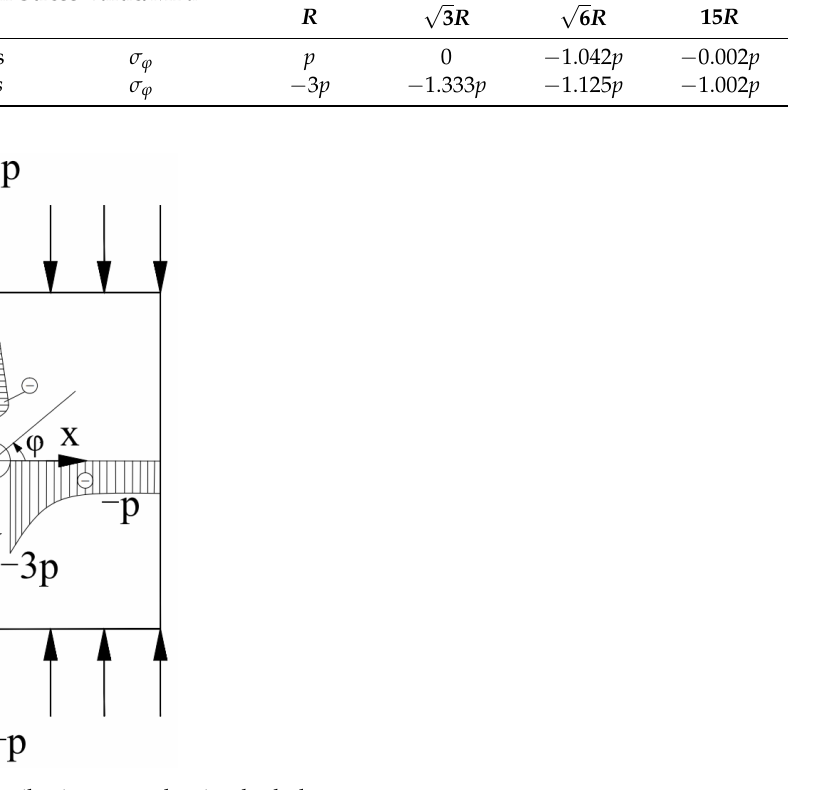
Figure 17. Stress distribution around a circular